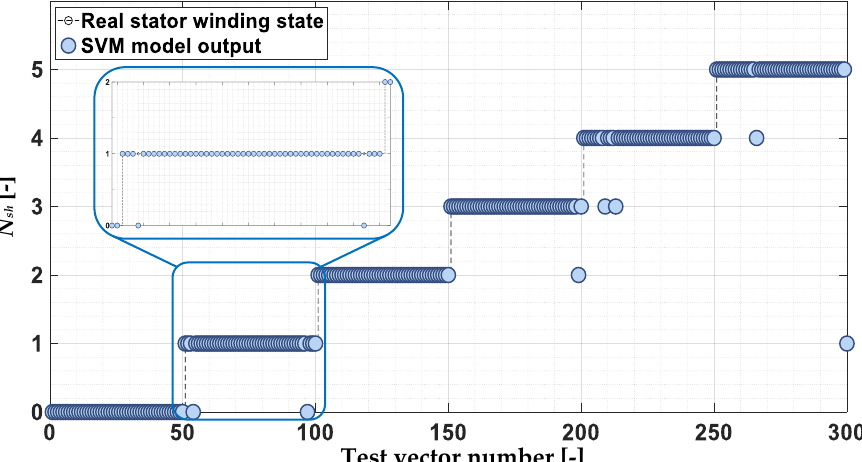
Figure 17. Response of the SVM stator winding fault classifier response to the test data set.